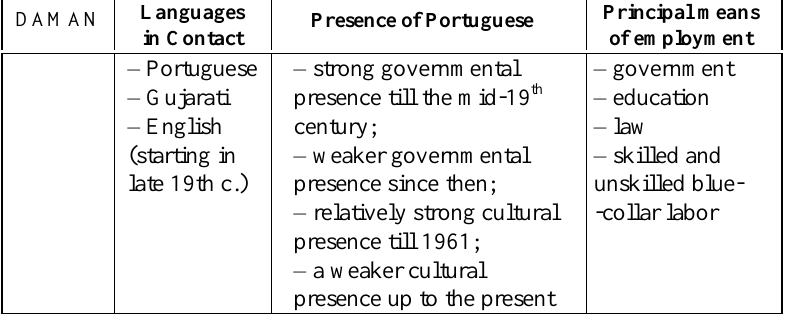
Table IV. Information on the Daman Christian community